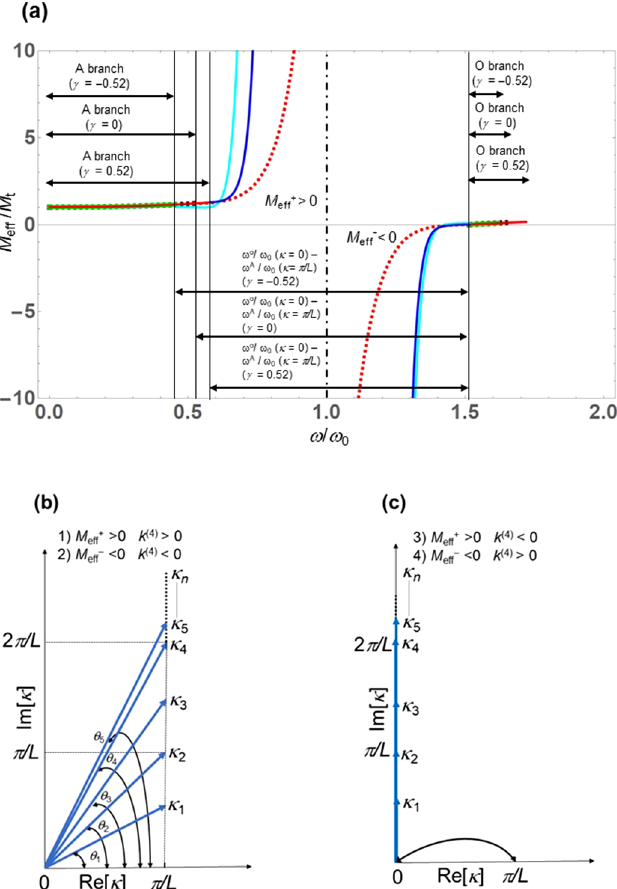
Fig. 2. ( a ) Effective mass as a function of the angular frequency in the propagating A and O regions and in the BG region. Dotted black lines: harmonic regime in the propagating region. Solid red lines: hardening anharmonic regime in the propagating region. Solid green lines: softening anharmonic regime in the propagating region. Dotted red lines: harmonic regime in the BG region. Solid blue lines: hardening anharmonic regime in the BG region. Solid cyan lines: softening anharmonic regime in the “ BG ” region. ( b ) Representation of the complex wave vector ( k = p / L + i Im [ k ]) in the complex plane for 1) M eff + > 0 Kg and k (4) > 0N/m 3 and for 2) M eff (cid:1) < 0 Kg and k (4) < 0 N/m 3 . ( c ) As in panel ( b ) but k (4) > 0 N/m 3 . The double arrow marks the jump of the real part of the wave vector either from k =0 to k = p / L (case 3)) or from k = p / L to k =0 (case